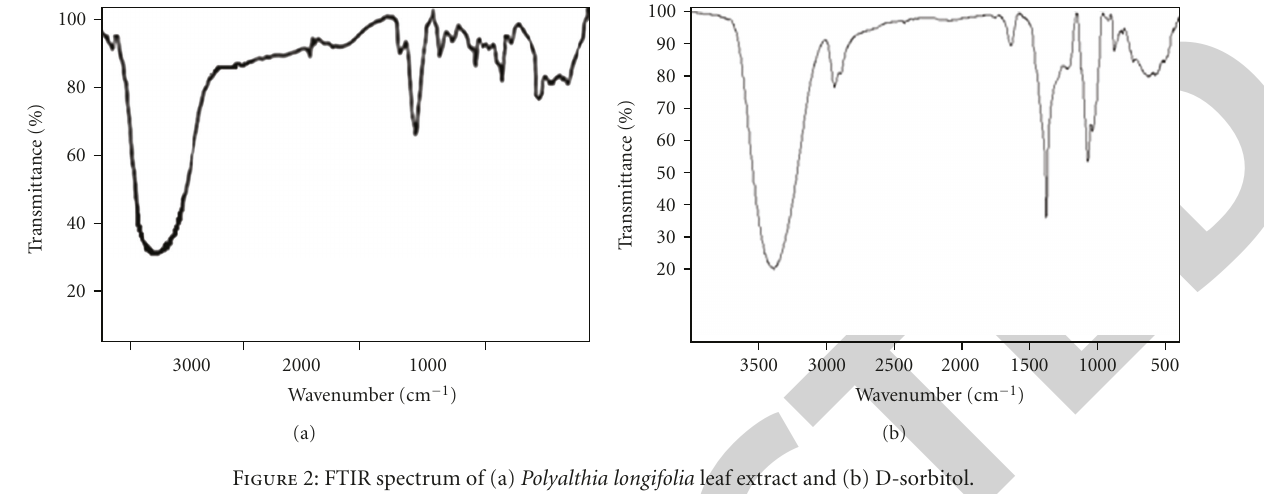
Figure 2: FTIR spectrum of (a) Polyalthia longifolia leaf extract and (b) D-sorbitol.